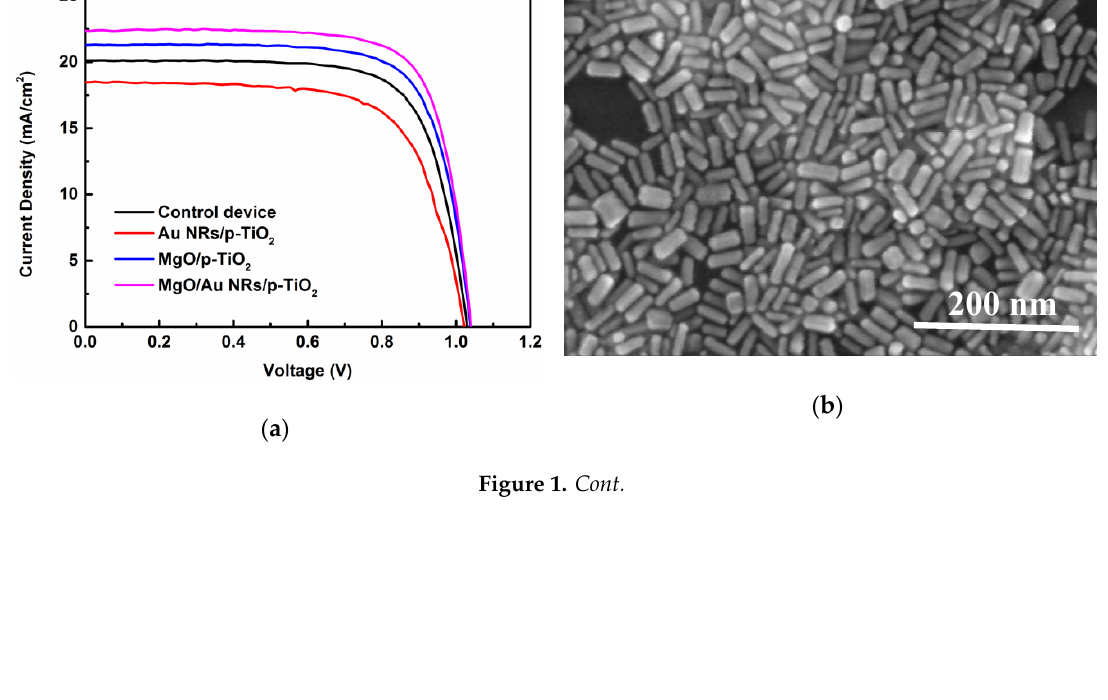
Table 1. Photovoltaic parameters of the PSCs based on m-TiO 2 with and without Au nanorods (NRs) and/or